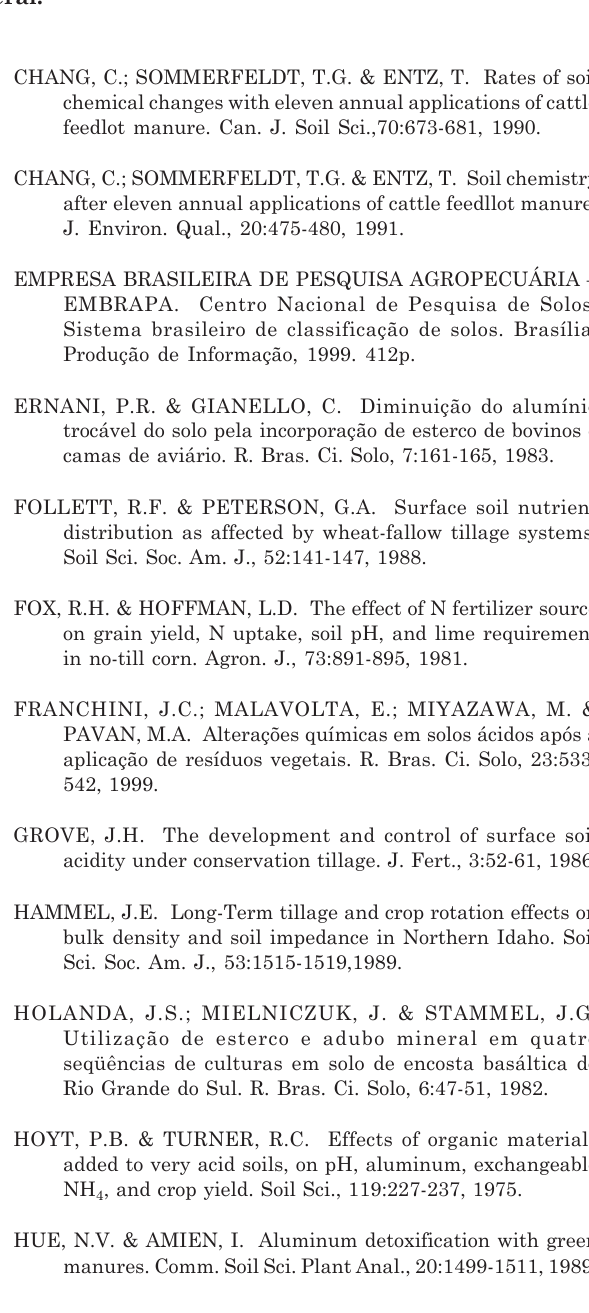
Figura 5. Saturação por bases (V) em Latossolo Bruno sob plantio direto submetido a diferentes doses de esterco líquido de gado de leite e adubação mineral, por um período de seis anos, com remoção total da planta: (a) adubação orgânica; (b) adubação